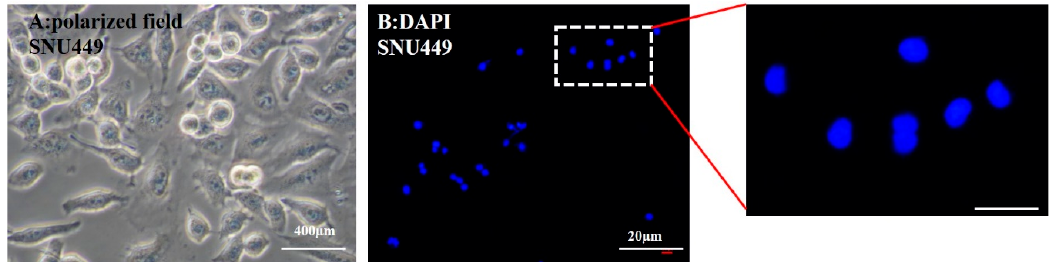
Figure 6. ( A ) Optical microscopy image of SNU449 after their exposure to 50 µg/mL free capsules for 24 h of incubation. ( B ) Fluorescence image of DAPI staining.